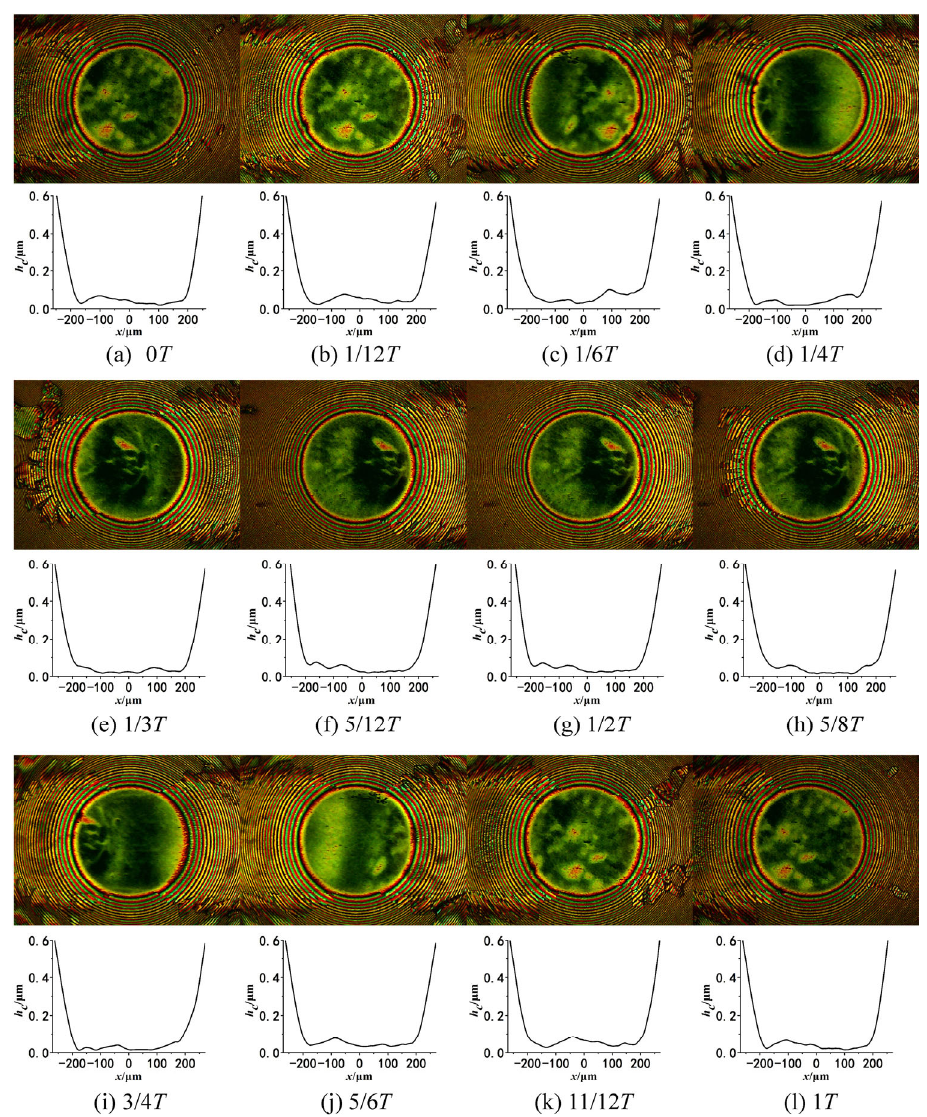
Fig. 13 Interferograms and midsection film thickness during 1,000th cycle under pure rolling reciprocating motion ( v max = 0.01 m/s, w = 50 N, T = 0.5 s, L = 1.25